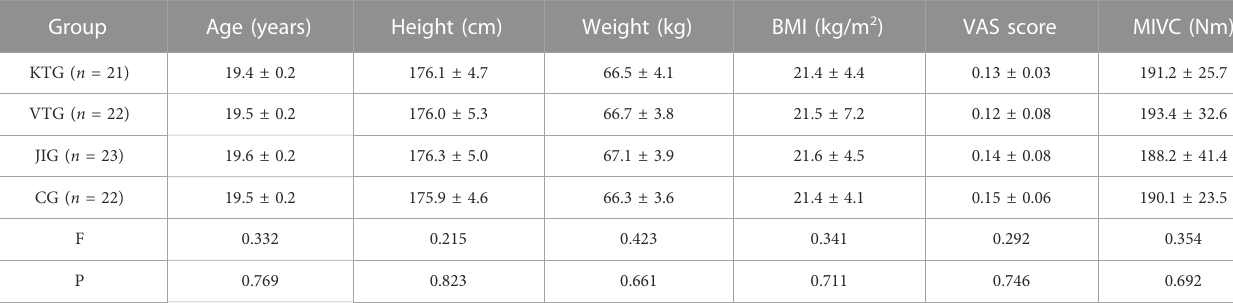
TABLE 1 Participants ’ basic information.